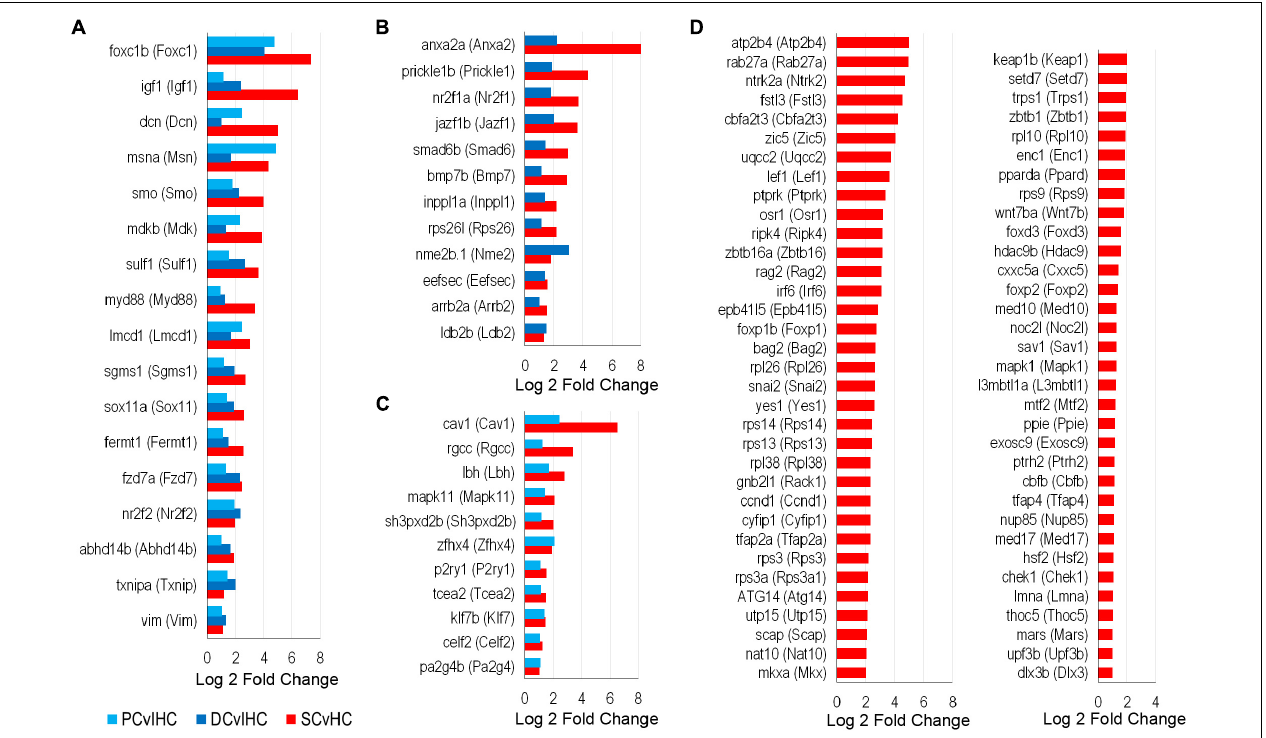
FIGURE 8 | Transcription factors classified as high-confidence orthologs upregulated among the supporting cell populations. (A) Transcription factors upregulated (FDR-adjusted p -value ≤ 0.05, log2 fold change ≥ 1.0) in zebrafish nsSCs and mouse PCs and DCs (corresponding mouse gene ortholog name in parentheses). Log2 fold change values of zebrafish nsSCs compared to HCs, and mouse PCs or DCs compared to IHCs are shown. Commonly upregulated transcription factors in nsSCs and DCs (B) or PCs (C) . (D) The 67 high-confidence gene orthologs encoding transcription factors that are uniquely upregulated in zebrafish